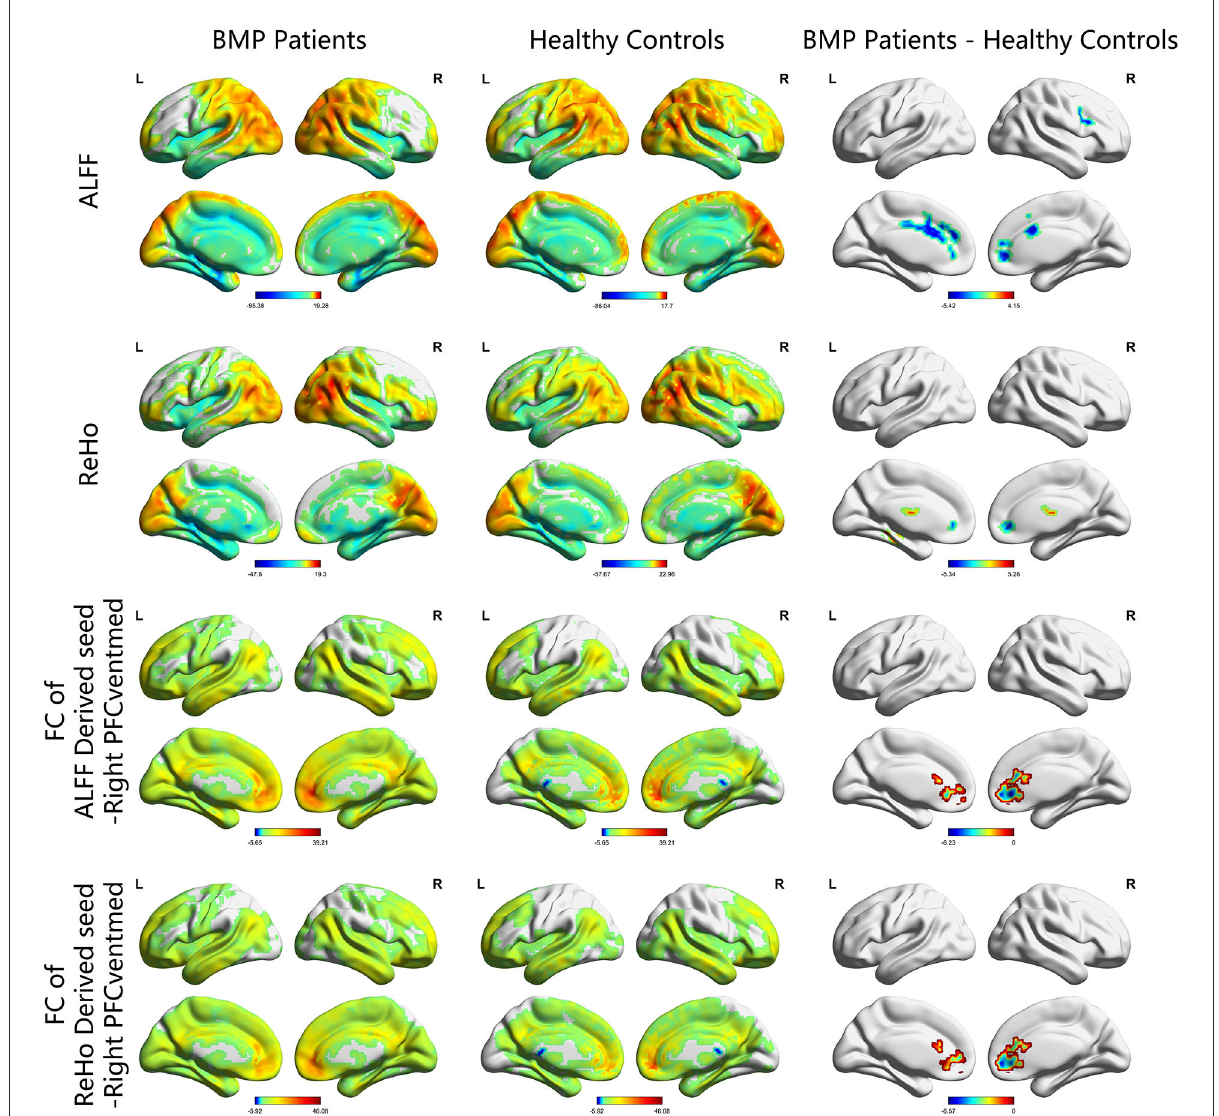
FIGURE1 ALFF, ReHo, and FC maps of intragroup and intergroup comparisons. Corrected for multiple comparisons with Gaussian random-field theory (voxel level p < 0.001, cluster level p < 0.05). The color scale denotes the t value. ALFF, amplitude of low-frequency fluctuations; ReHo, regional homogeneity; FC, functional connectivity; PFCventmed, superior frontal gyrus, medial orbital; R, right; L,